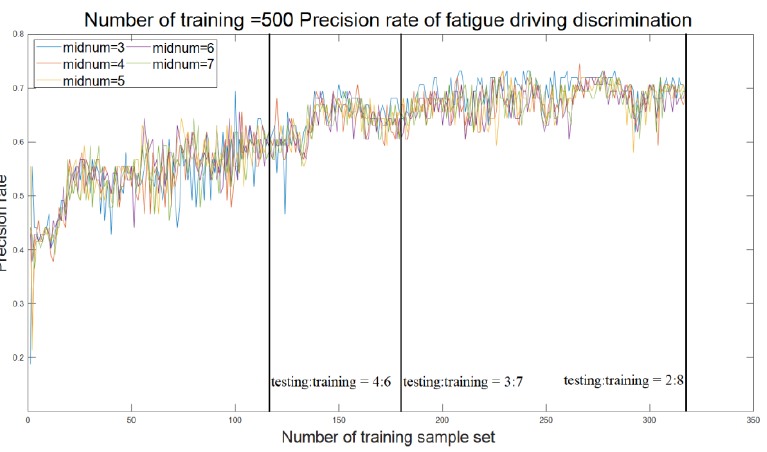
Figure 8. Accuracy of fatigue driving behavior detection varying with the number of training samples when the training times is 500.